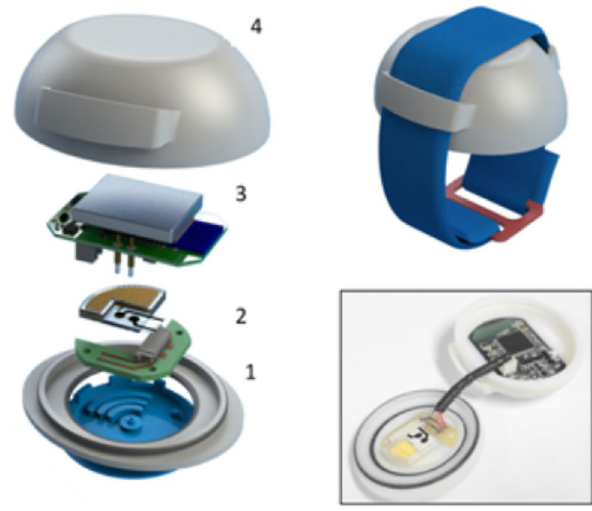
Fig. 7 SwEatch: watch- sensing platform for sodium analysis in sweat. 1: sweat har- vesting device in 3d-printed platform base, 2: fluidic sensing chip, 3: electronic data logger and battery, and 4: 3d-printed upper